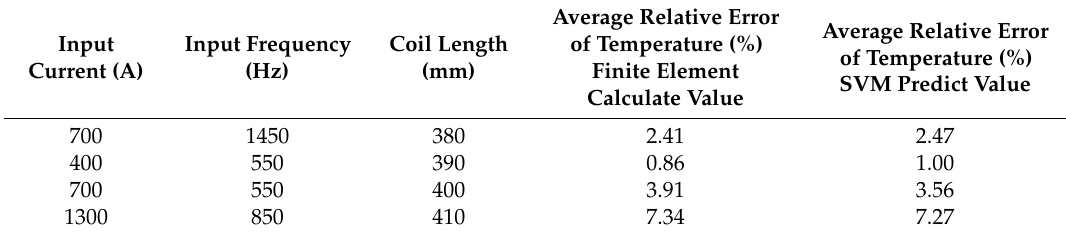
Table 3. Prediction results of average relative error of strip temperature at outlet of device by support vector machine.